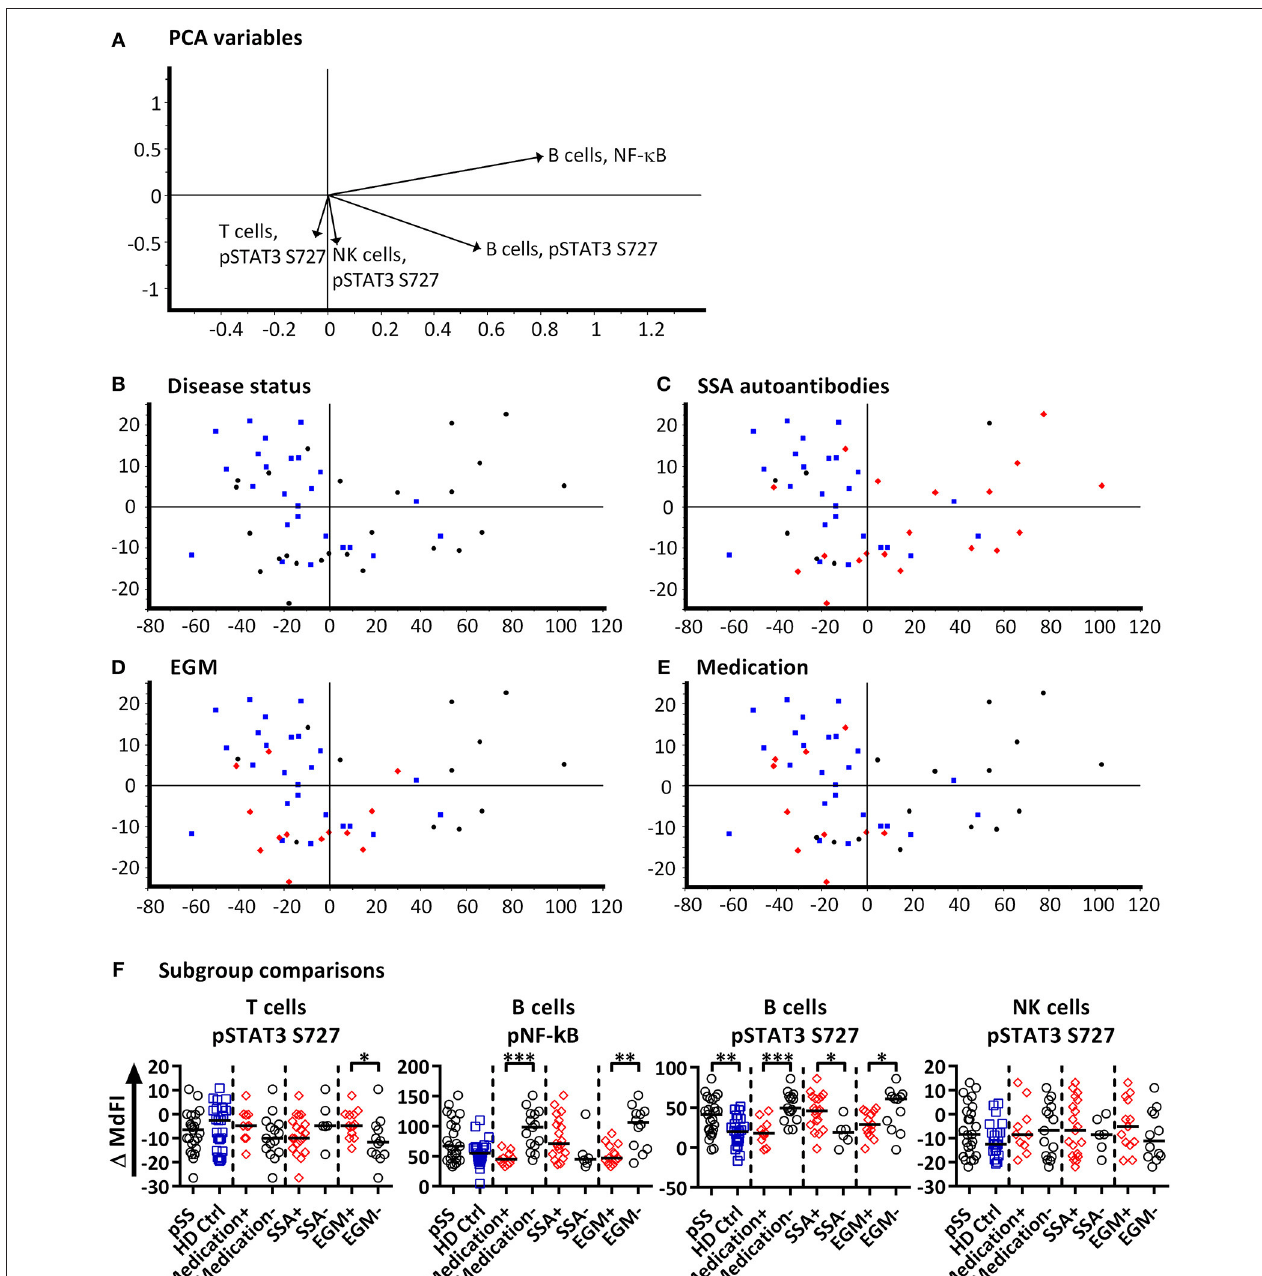
FIGURE 3 | PCA analysis of induced phosphorylation in PBMC at 15min following stimulation with TLR 7 and − 9 ligands. Groupings of samples by PCA are shown by disease status (B) , SSA autoantibody positivity (C) , EGM presence (D), and medication use (DMARDs or corticosteroids) (E) . Healthy donor samples are indicated by blue squares, pSS patients as black circles, and pSS patients with SSA autoantibodies, EGM or using prescribed DMARDs or corticosteroids ( C–E, respectively) displayed as red diamonds. The loading plot, which contains information about the variable for the corresponding PCA is shown in (A) , with variables contributing to the PCA given as vectors. Variables contributing little to the PCA are plotted around the center as denoted by the gray axis, while variables that have high contributions are plotted further from the axes. After initial calculation of principal components the model was recalculated with only variable explaining > 50% of the variance retained, stepwise reduction of less significant variables with low variable leverage was then performed. Scatter box plots of variable used in PCA for TLR7 and − 9 ligand induced responses are given in (F) . Figures show change in MdFI from 0 to 15min (Y axis) following addition of TLR7 and − 9 ligands to PBMC cultures. Measured phospho-protein and responding cell type are labeled above each figure. Groups are identified at the base of each figure (X axis), initially with pSS patients (pSS) and healthy donors (HD Ctrl), pSS patients are further divided into SSA autoantibody positive and negative patients, patients with EGM (EGM + ) or without EGM (EGM–), and unmedicated and medicated patients. Statistical comparisons were made between each of these pairs as indicated by dashed lines, with black bars representing medians. The data represents 25 healthy controls and 25 patients pooled from 13 independent experiments. Comparison between pairs were conducted using an Unpaired Mann-Whitney test with significance indicated as * ≤ 0.05, ** ≤ 0.01 and *** ≤ 0.001.